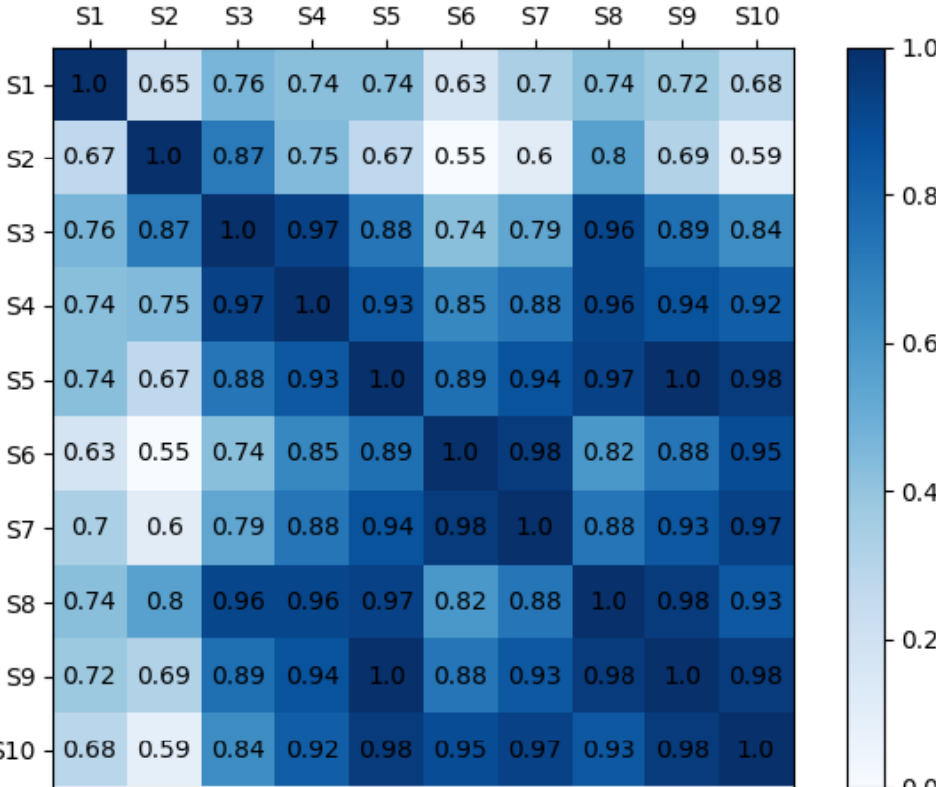
Figure 5. Selectivity of the initial sensor array to the experimental gases.